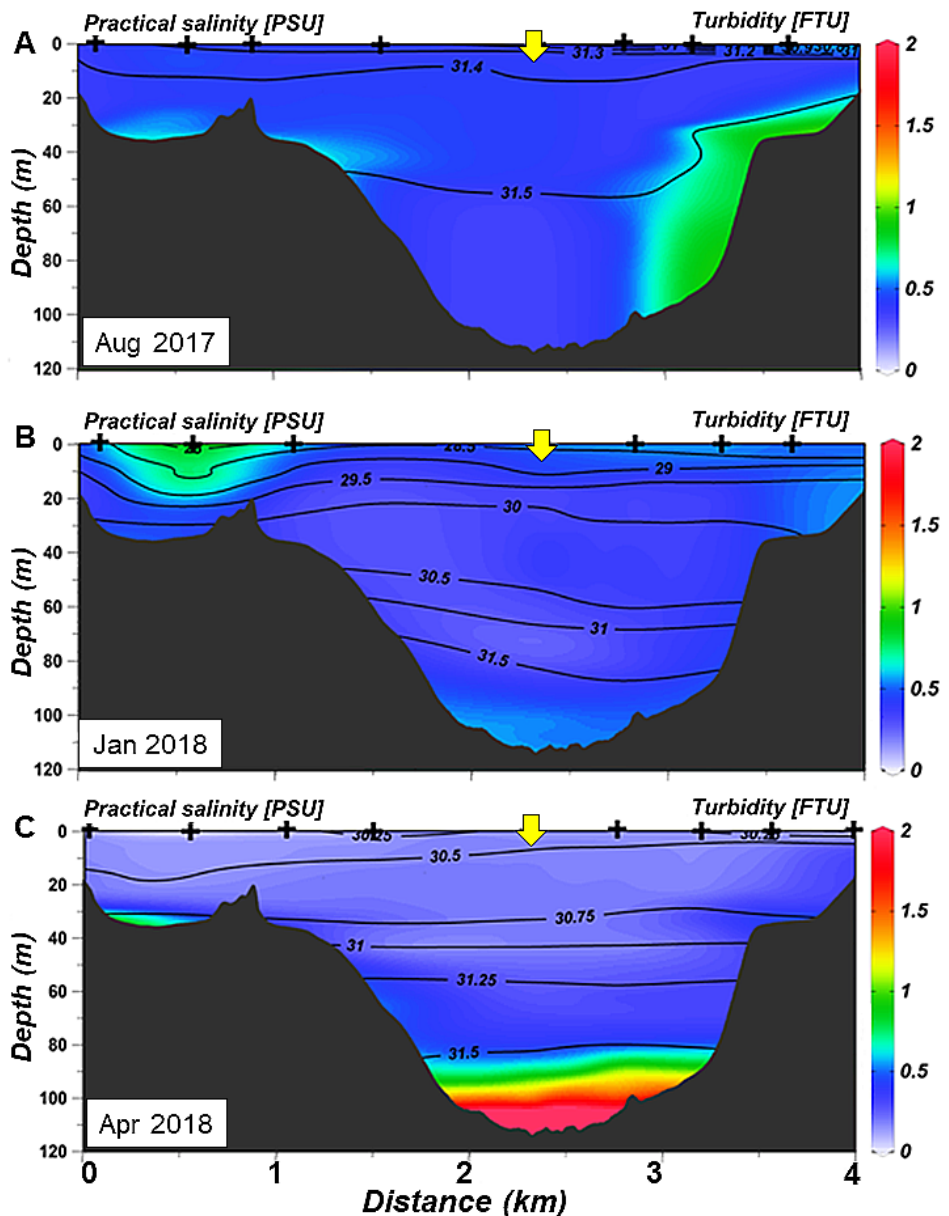
Figure 4. Cross-bay section of turbidity (color gradient) and salinity (isolines) for ( A ) August 2017; ( B ) January 2018; and ( C ) April 2018. The intersection between cross-bay and along-bay sections is marked with a yellow